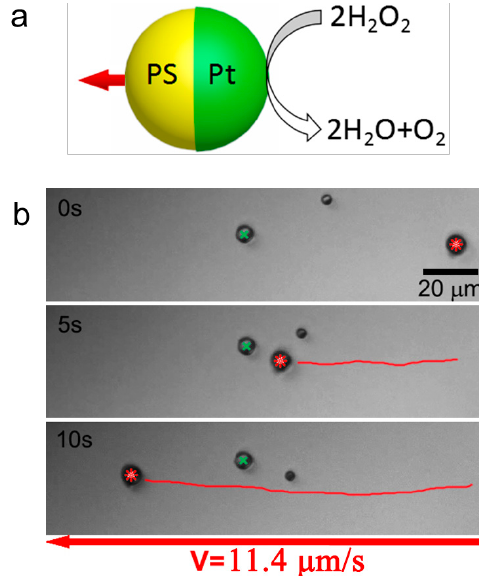
Figure 4. ( a ) Schematic illustration of the self-propelled Janus motors and ( b ) video snapshots of the motion of a micro-motor (red) with the addition of peroxide (3 wt %), without any surfactant. (The green particle stands as a reference particle.)